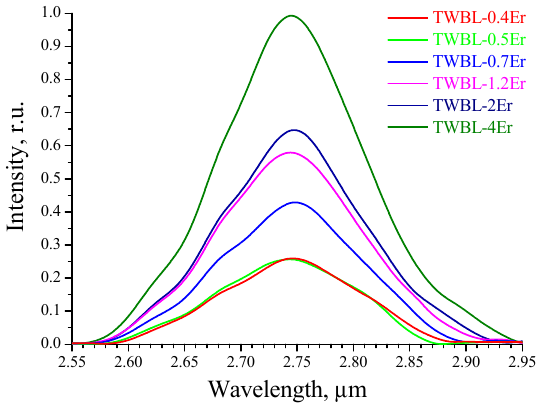
Figure 9. Luminescence band of Er 3+ at 2.75 µm of the TeO 2 -WO 3 -Bi 2 O 3 -(4-x)La 2 O 3 -xEr 2 O 3 glasses with different Er 2 O 3 contents. Excitation 975 nm, 0.5 W.